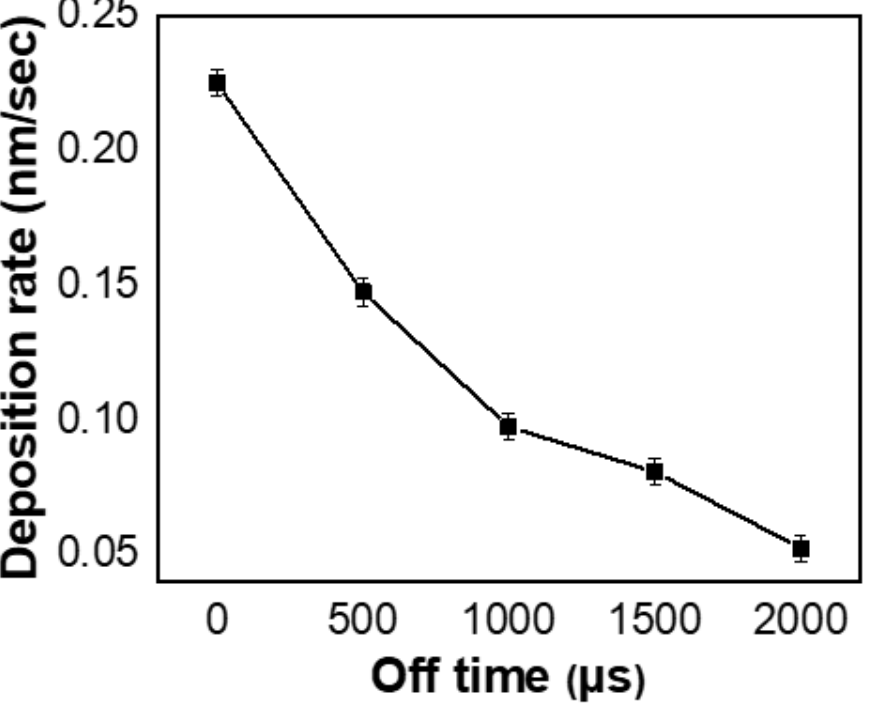
Figure 2. Deposition rate at different pulse off-times. Table 3. Atomic concentration of ITZO films deposited at different pulse